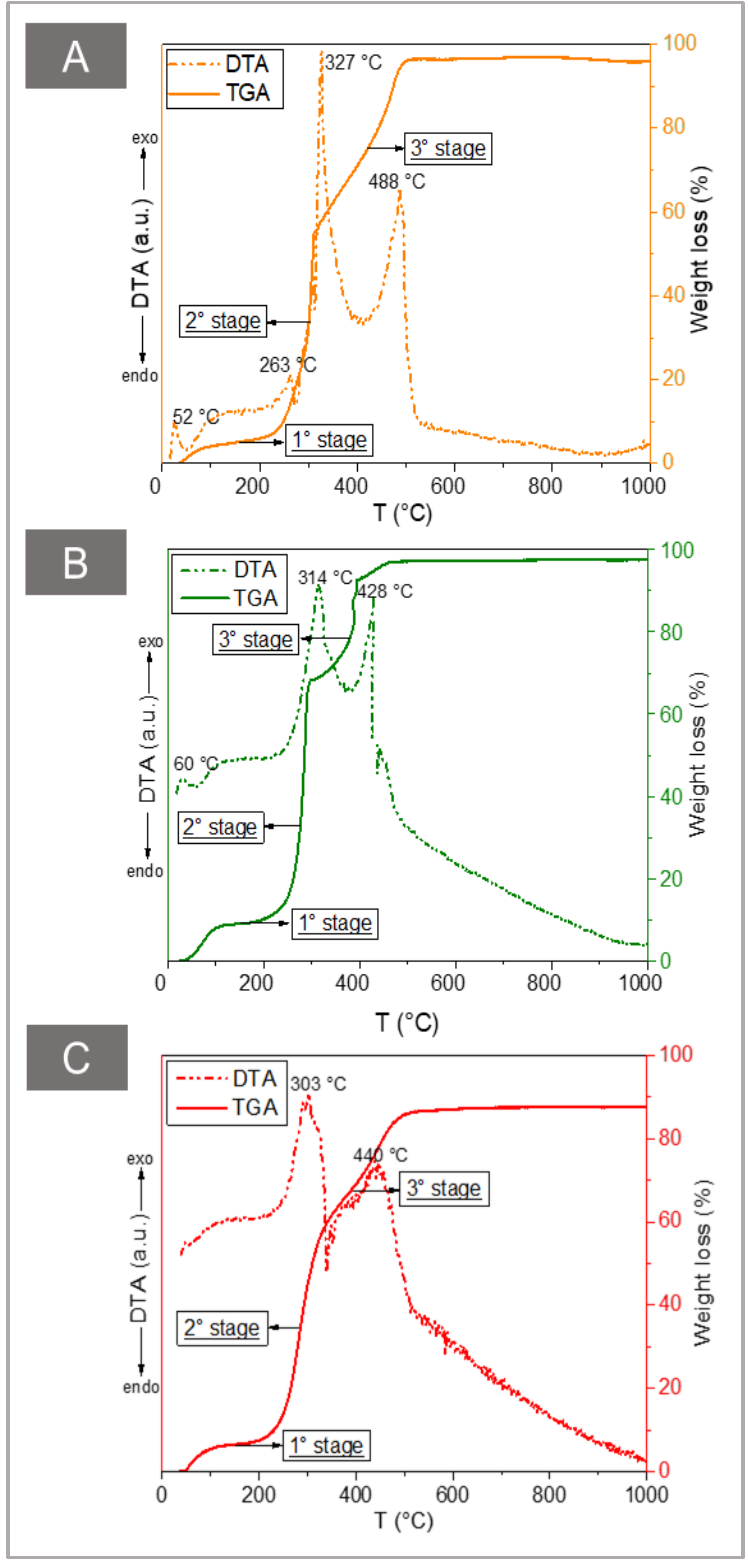
Figure 8. DTA-TGA of: ( A ) pine sawdust, ( B ) sunflower seed hulls, ( C ) corn residues mix.